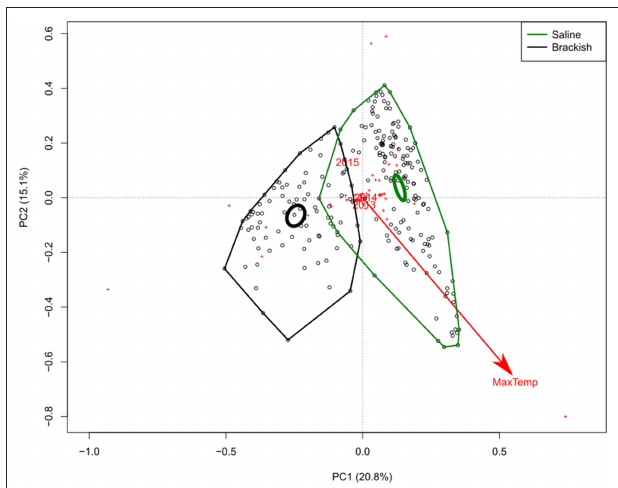
FIGURE 1 | PCA axes 1 and 2 with the samples (black dots) of the full dataset, including both locations. Red plusses indicate the position of the different taxa. A polygon is drawn through all the outer sample points for each location (green for the saline location; black for the brackish location) and the inner thick circle indicates the 95% confidence interval of the centroid for the two locations. The environmental factors that significantly correlate with the samples are indicated by a red arrow for continuous variables or red names for factors with multiple